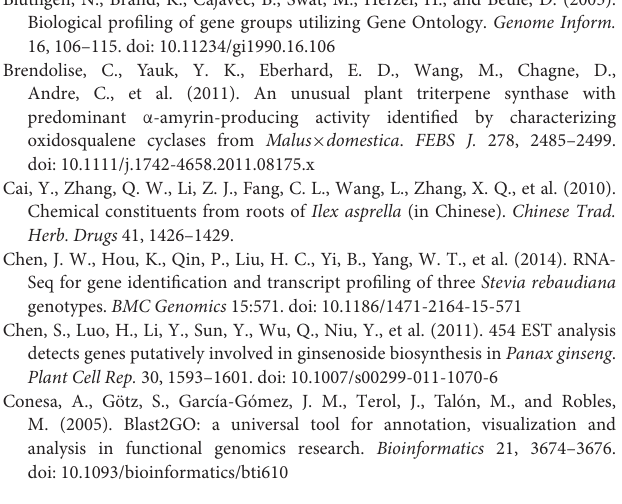
Figure S10 | Characteristics of CYPs in I. pubescens. (A) Distribution of the CYP families; (B) Length distribution of these CYPs; (C) RPKM distribution of the CYPs; (D) GO classify of CYPs in I. pubescens . Figure S11 | Phylogenetic analysis of the well-characterized UGTs involved in pentacyclic triterpenoids biosynthesis. The statistical methods of this unrooted tree were the same as Figure S9 and glucosylation positions on amyrin are indicated. The open stars, black stars and black triangles indicate the UGTs clustered together with the UGT73, UGT74, and UGT91 clans, respectively. Bv, Barbarea vulgaris subsp. arcuate ; Gg, Glycyrrhiza glabra ; Gm, Glycine max ; Mt, Medicago truncatula ; Sv, Saponaria vaccaria . Figure S12 | Distribution of homologous genes and specific genes in I. pubescens and I. asprella. Figure S13 | Distribution of Ka/Ks ratio. Ortholog pairs with Ka/Ks ratio > 1 are above the full line, while ortholog pairs with Ka/Ks ratio between 0.5 and 1 reside between the full and imaginary lines. Figure S14 | Phylogenetic analysis of the well-characterized CYPs involved in diterpenoids and triterpenoids biosynthesis. The statistical methods of this unrooted tree was the same as Figure S9 . The black stars indicate the CYPs were involved in diterpenoids biosynthesis. Gb, Ginkgo bilobaSm ; Sm, Salvia miltiorrhiza ; Tca, Taxus canadensis ; Tcu, Taxuscuspidata ; Tx, Taxusx media . Figure S15 | Comparison of amino acid sequence of IpAS 1 amd IaAS 1. QW, DCTAE, MWCYCR and PVRXXE motif were demonstrated with red solid frame, red line, black solid line and black line, respectively. Table S1 | Identified pentacyclic triterpenoids in I. pubescens . Table S2 | Identified pentacyclic triterpenoids in I. asprella. Table S3 | Information of Characterized CYPs and UGTs for Blastp analysis. Table S4 | Designed primers for IpAS1 cloning. Table S5 | The CYPs with length > 1,000 bp and classified as CYP72 clan and CYP85 clan in I. pubescens. Table S6 | Putative Ilex-genus-specific CYP